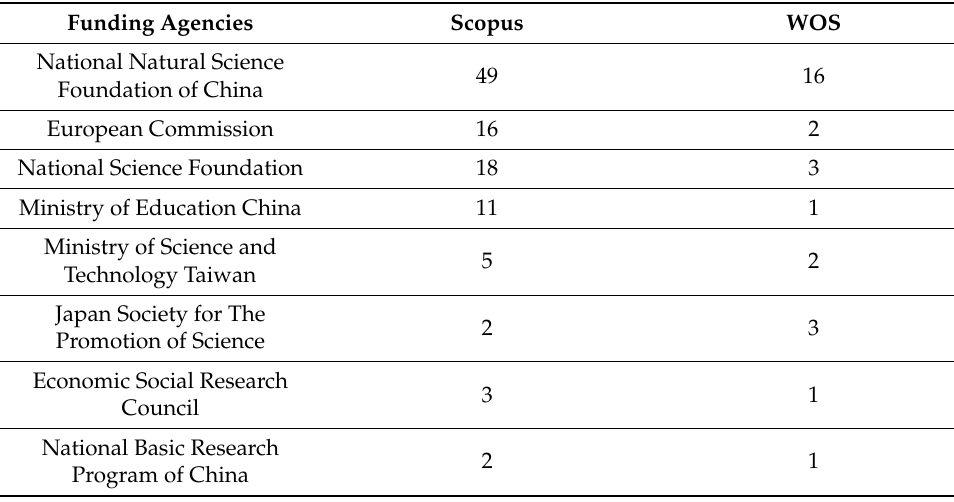
Figure 8. Combined analysis of funding agencies from Scopus and Web of Science. Table 10. Prominent funding agencies combined from Scopus and Web of Science.